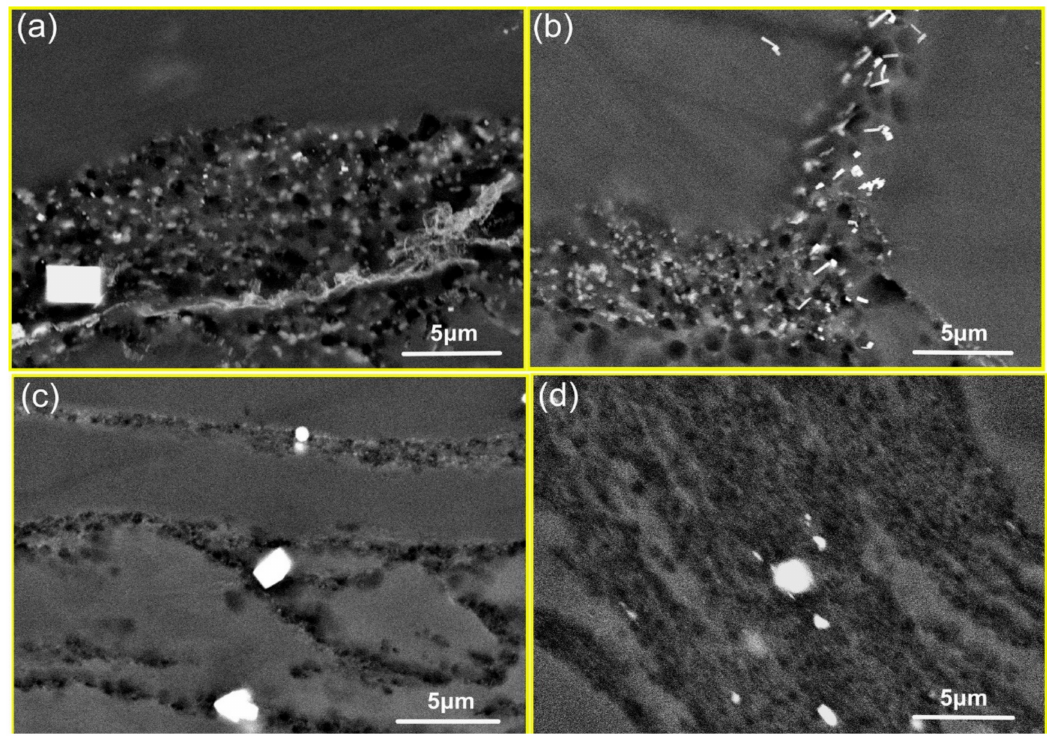
. ε = 0.002 s − 1 and T = 350 ◦ C, ( b ) . ε = 1 s − 1 and T = 350 ◦